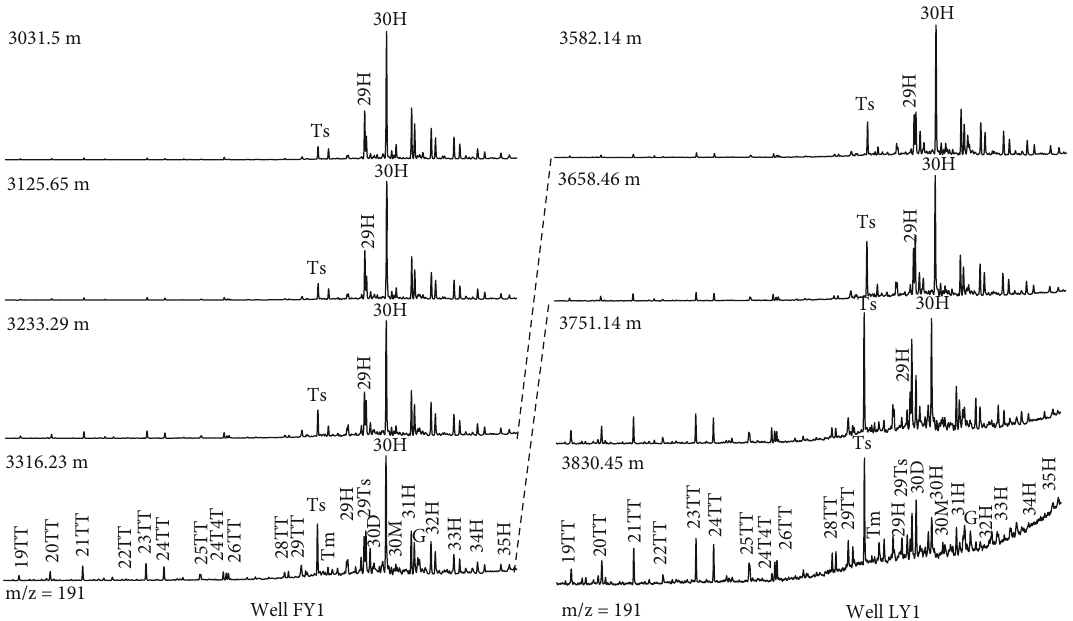
Figure 3: Mass chromatograms of m/z = 191 of the saturated hydrocarbon fraction showing the typical distribution of terpanes with increasing burial depth in wells FY1 and LY1. 19-29TT: C trisnorhopane; 29-35H: C -C 17 α (H),21 β (H) hopanes; 29Ts: 8 α (H)-30-norneohopane; 30D: C 29 35 17 β (H),21 α (H)-hopane norhopane); 30 M: C 30